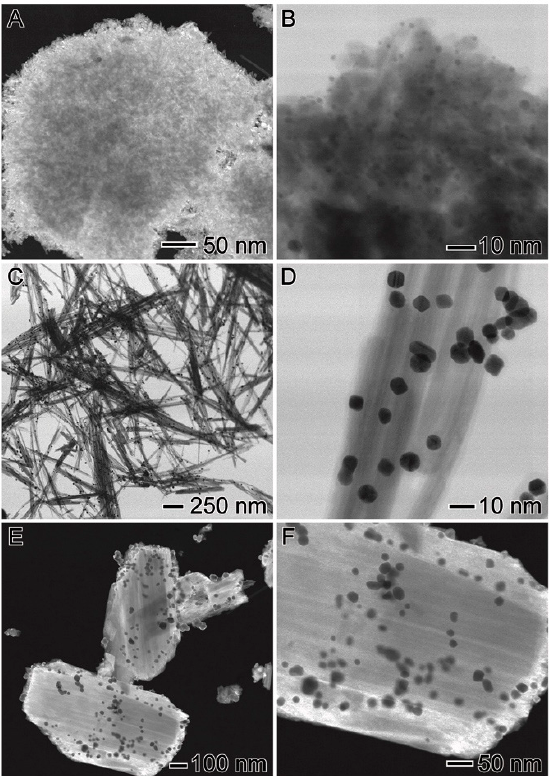
Figure 4. TEM studies of the spent catalysts: Au/MnO 2 -NF ( A , B ), Au/MnO 2 -NW ( C , D ) and Au/MnO 2 -Comm ( E , F) .